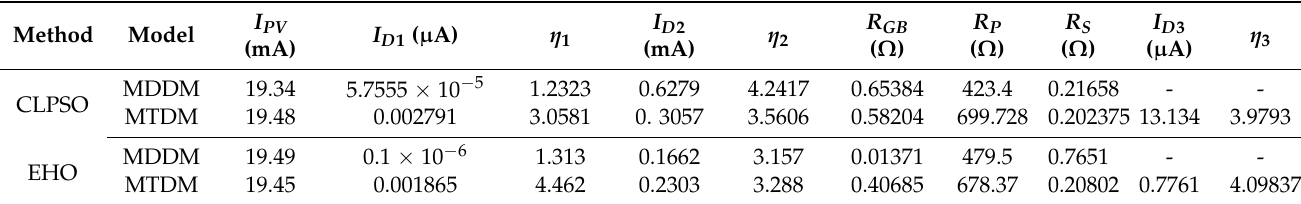
Table 2. Estimated MDDM and MTDM parameters by CLPSO and EHO algorithms for Q6-1380 solar cell at the irradiance level (9.84 mW/cm 2 ) and room temperature (300 K).